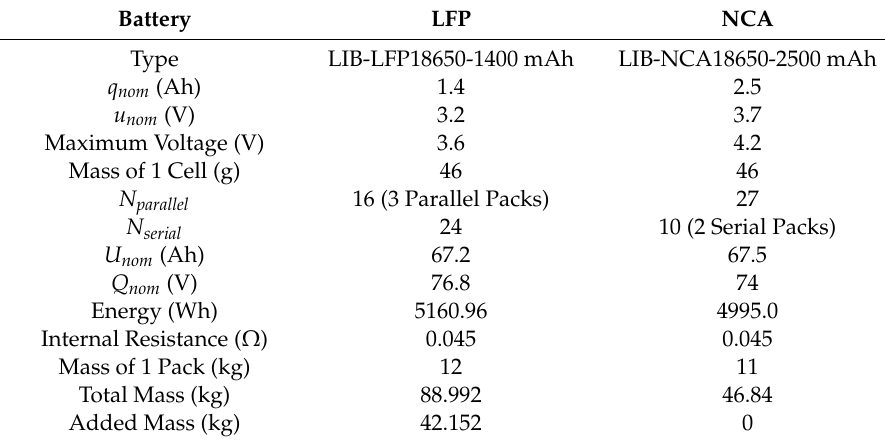
Table 3. Battery